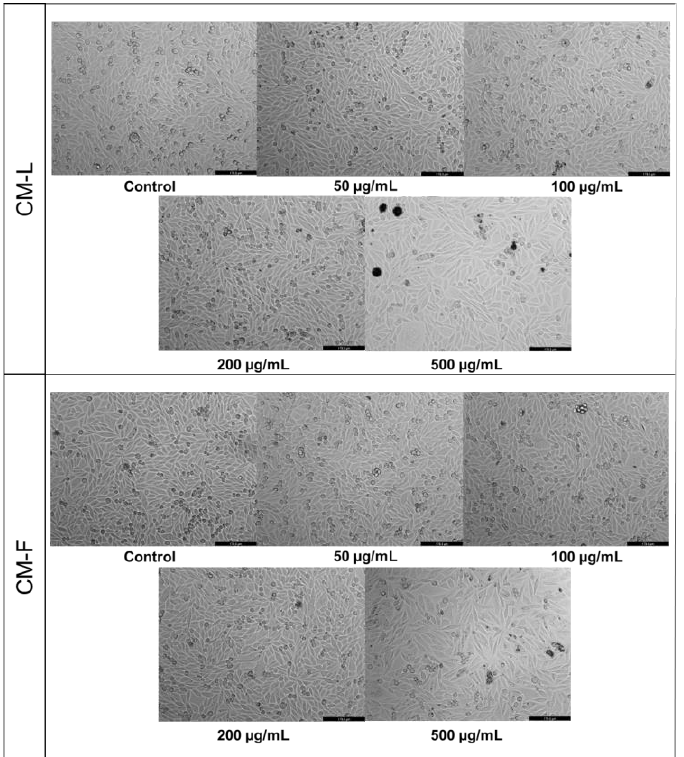
Figure 6. Morphological evaluation of PC-3 cells after 48h of treatment with Cladanthus mixtus ex- tracts. Results are representative of three independent experiments. Scale bar: 200 µm.